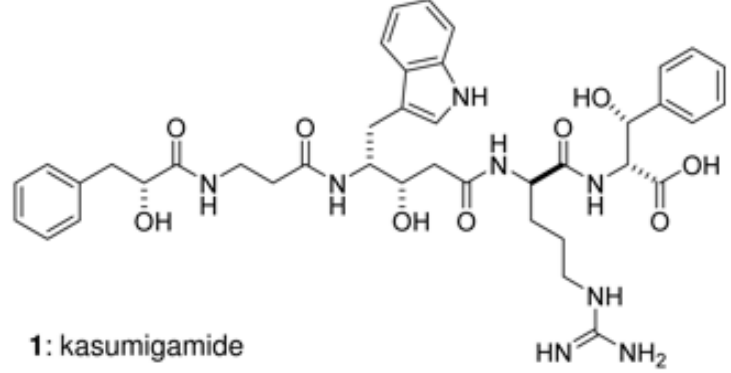
Figure 3. The molecular structure of kasumigamide an antialgal tetrapeptide [162].